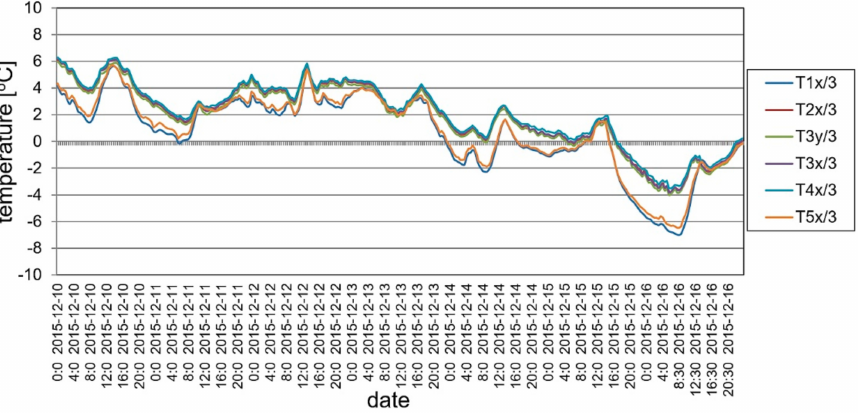
Figure 24. Temperature changes during a one week period.